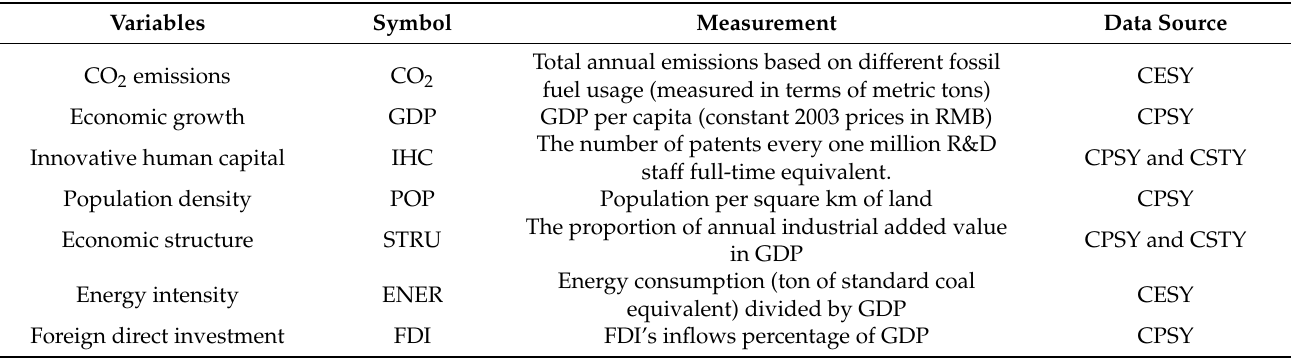
Table 2. Variable’s measurement, symbol, and data